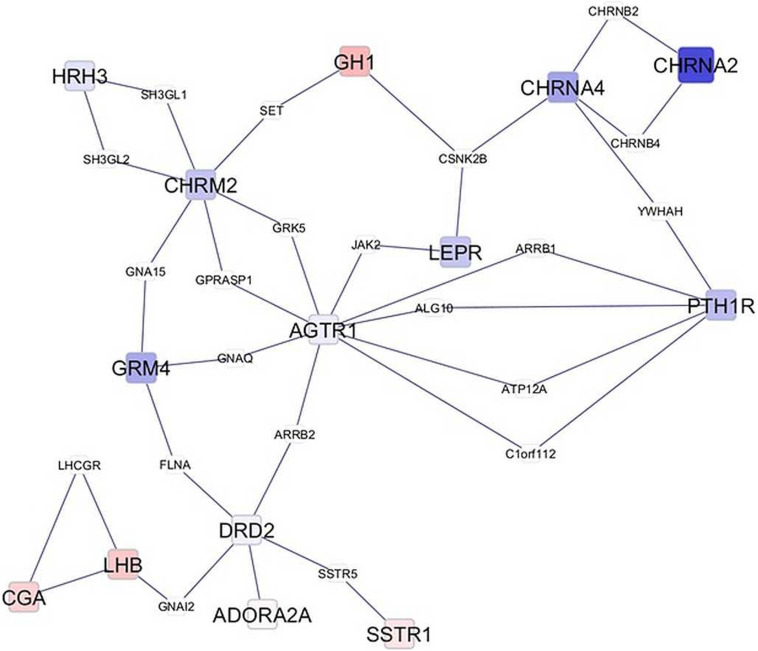
Network of genes differentially expressed in the amygdala of females (Fe) from control (CON) relative to maternal immune activation (MPA) (contrast between CON_Fe and MPA_Fe). Framework square node color: red and blue denote framework genes over- and under-expressed in CON relative to MPA pigs, respectively; framework node size: -Log10[P-value]; other genes connecting framework nodes were not differentially expressed in this study.